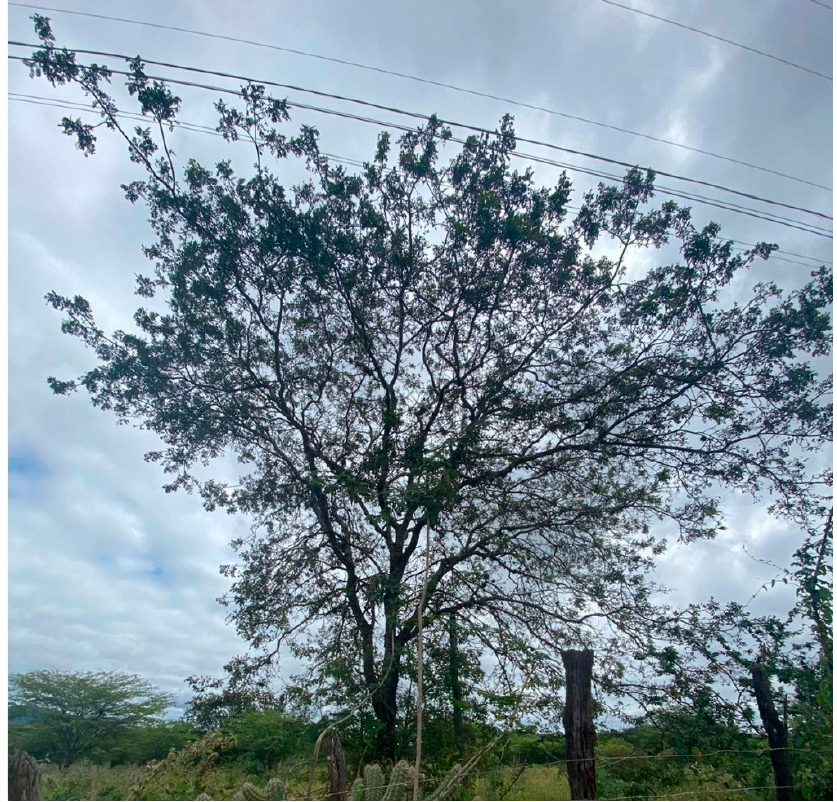
Figure 1. Schinopsis brasiliensis Engl. Image captured by the authors (Arcoverde/Pernambuco/Brazil—